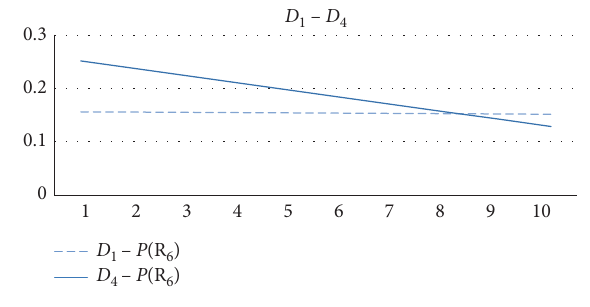
Figure 4: Sensitivity analysis of D